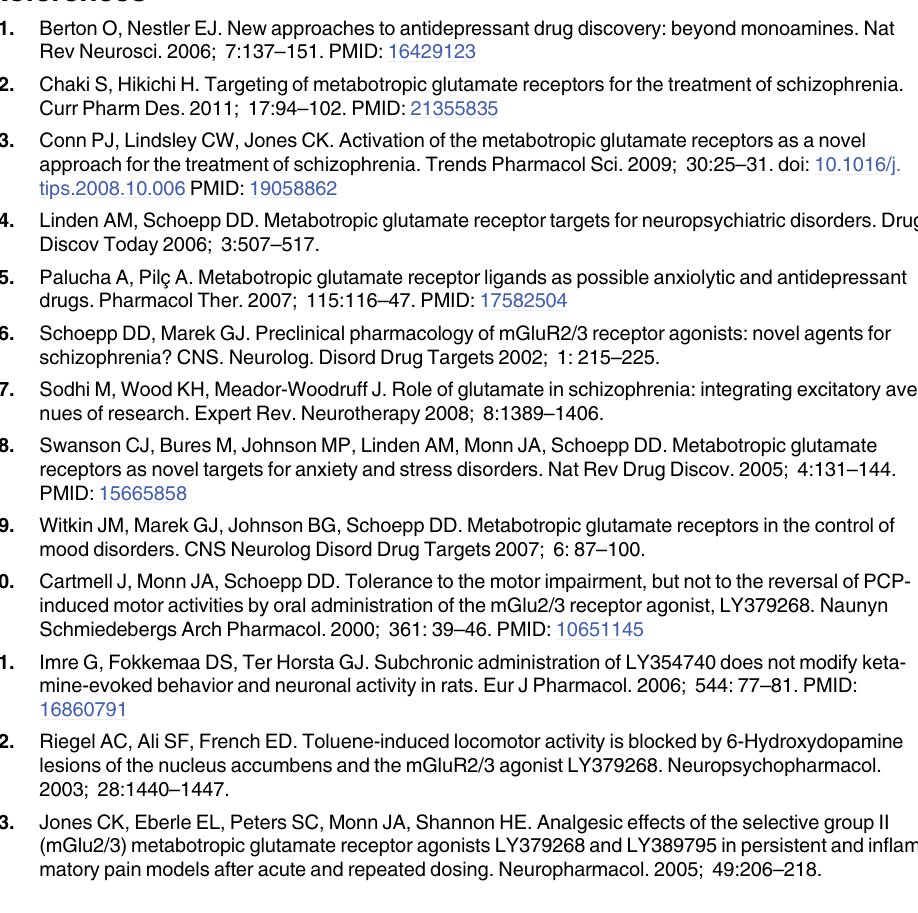
S3 Fig. Binding site amino acid comparison, human mGluR2 is highlighted in the red box. Amino acids are non-sequential and identified by selecting within 6Å radius of ligand in mGluR1 and mGluR5 crystal structures, selected examples from mGluR2 are labelled. (TIF) S4 Fig. Overlap of the proposed binding mode of JNJ-42153605 (magenta) binding mode with that of JNJ-46281222 (blue).